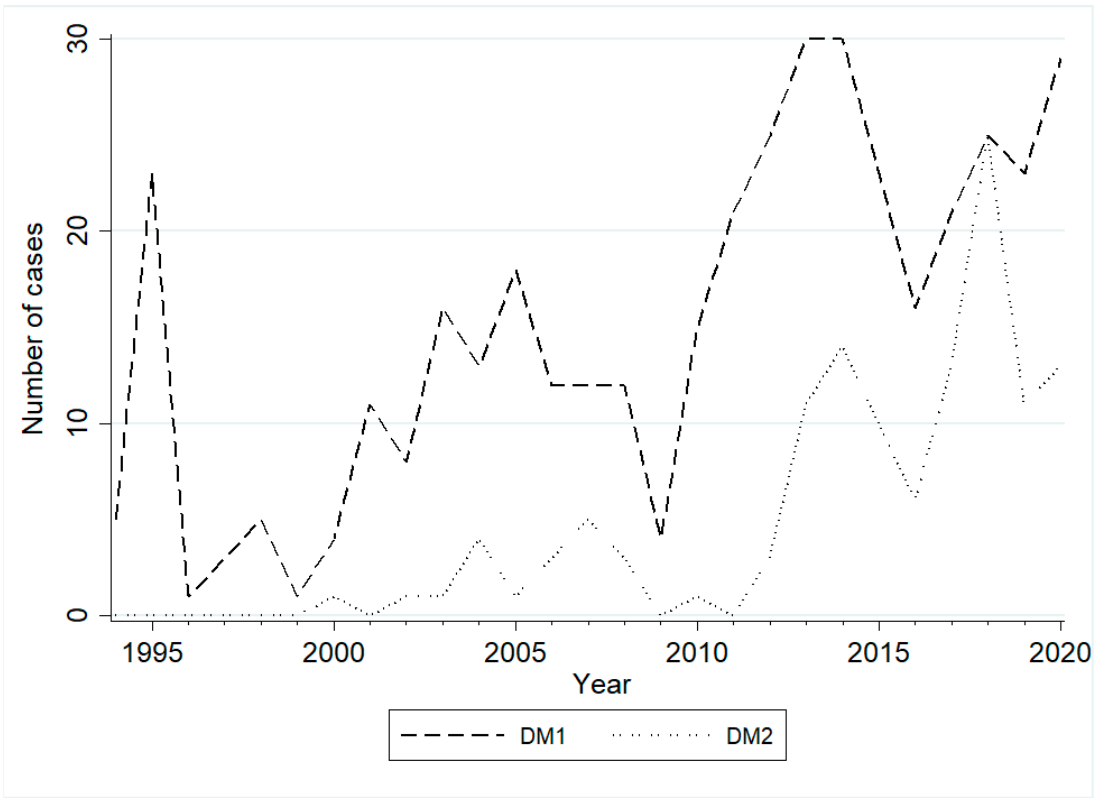
Figure 2. Number of cases diagnosed annually in both DM1 and DM2